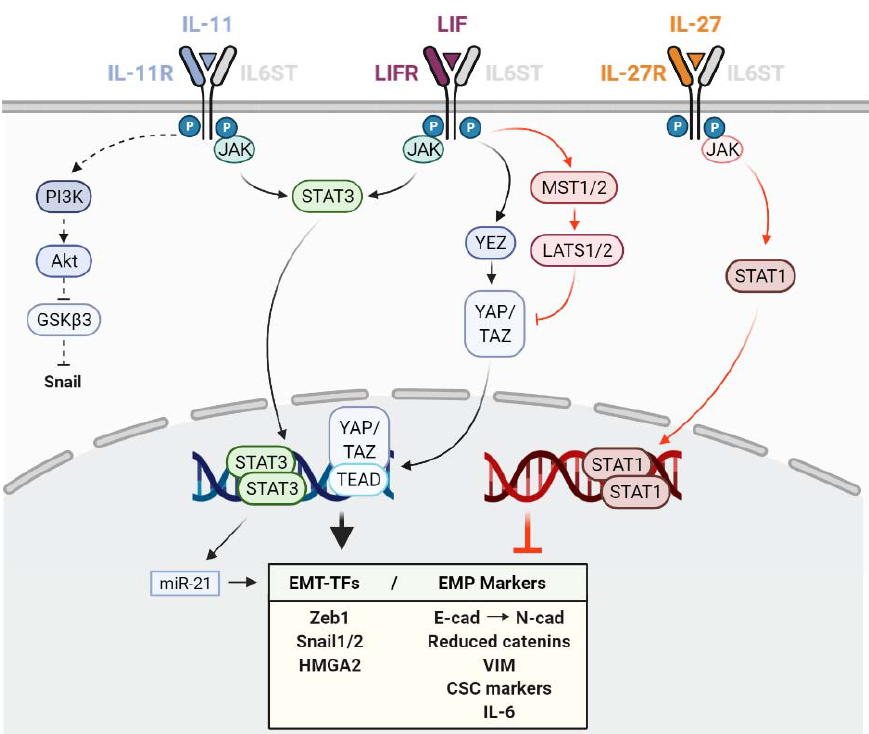
Figure 2. Schematic representation of the different effects of interleukin 11 (IL-11), leukaemia inhibitory factor (LIF) and interleukin 27 (IL-27) in epithelial–mesenchymal plasticity (EMP) and the downstream pathways and mediators involved. Black and red colours indicate pro- and anti-EMP functions, respectively. T arrows indicate inhibition. Dashed arrows indicate EMP promotion by EMT-TF protein stabilization. EMT-TFs: Transcription factors involved in EMP.